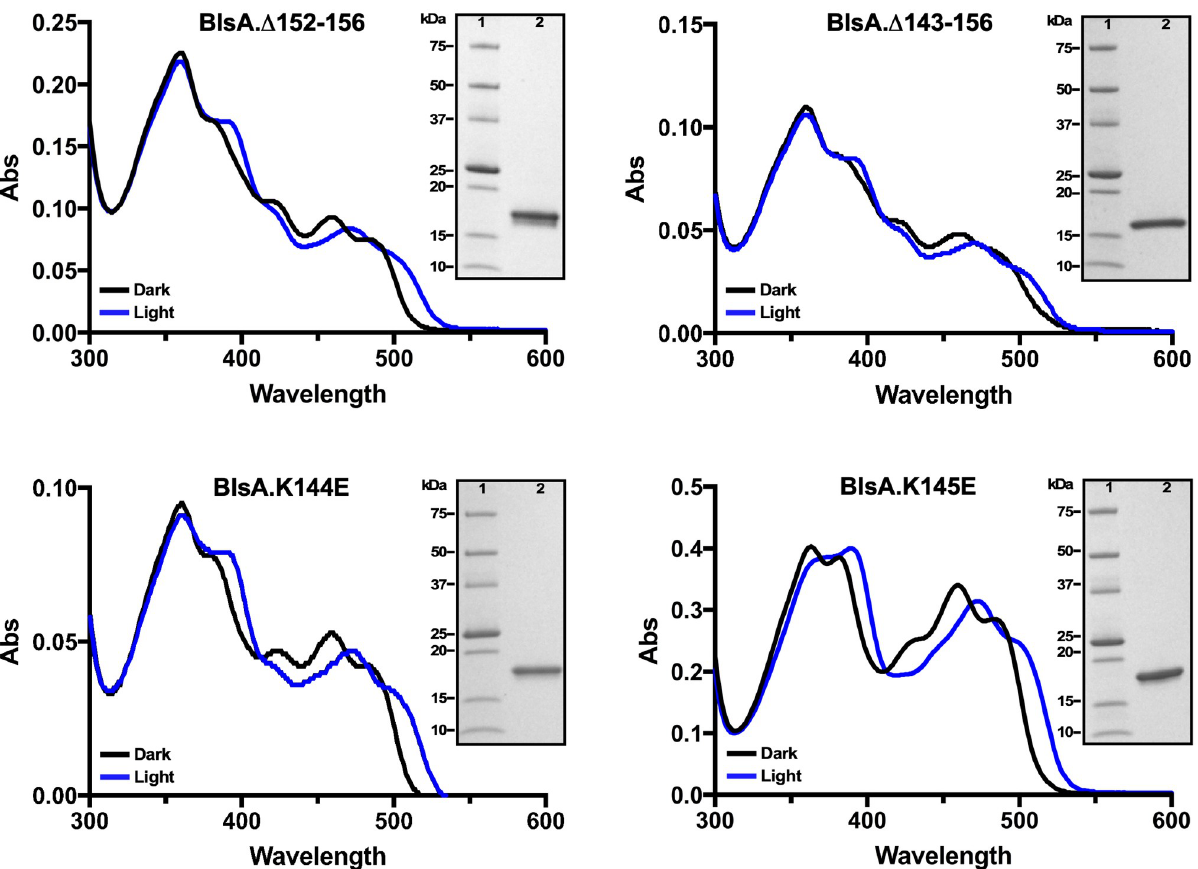
Fig 5. Spectral analysis of purified His-tagged BlsA derivatives generated by site-directed deletion and point mutagenesis. The UV-Vis light spectra were recorded using His-tagged BlsA derivatives purified by Ni-affinity chromatography and SEC. The purity of the protein samples used for spectral analyses was confirmed by SDS-PAGE using 4%-20% polyacrylamide gradient gels (insets).